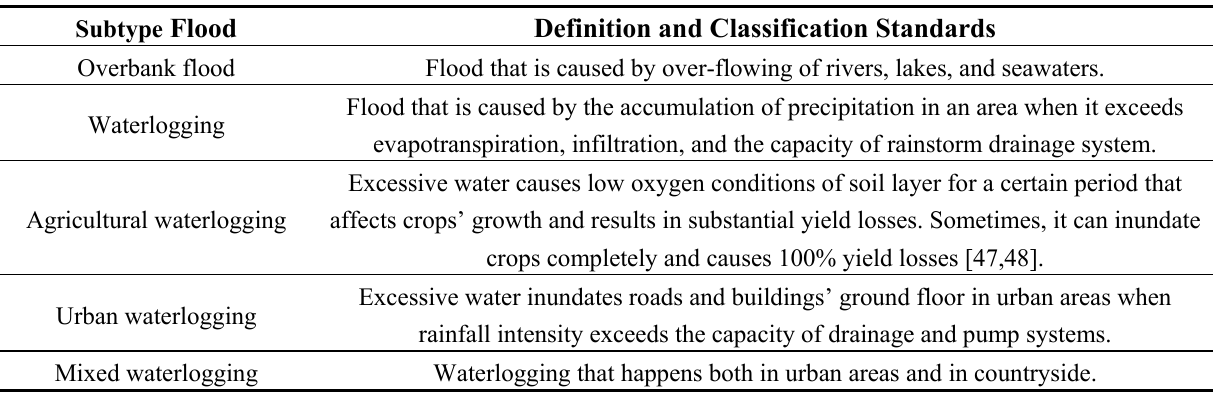
Table 1. The definition and classification standards for the five subtype